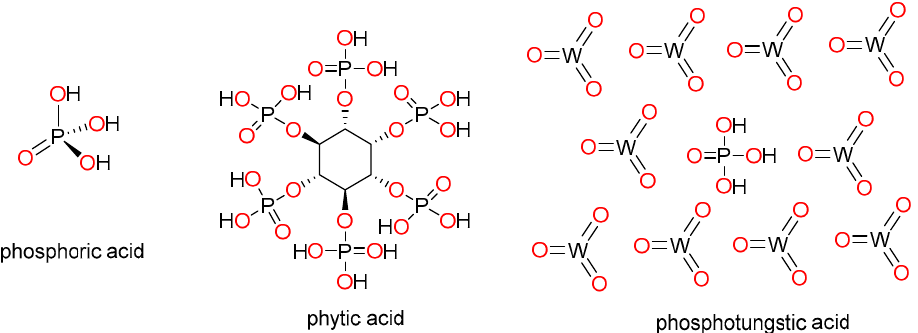
Figure 2. Chemical structures of phosphoric acid (PA), phytic acid, and phosphotungstic acid (HPW).